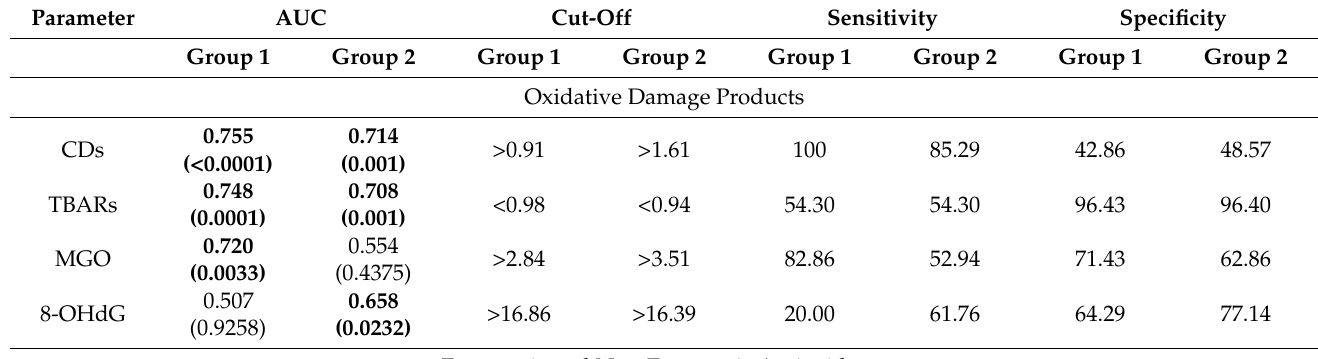
Table 6. ROC analysis of markers of oxidative damage products and total antioxidant status, enzy- matic and non-enzymatic antioxidant levels in men with T1DM Group 1 and